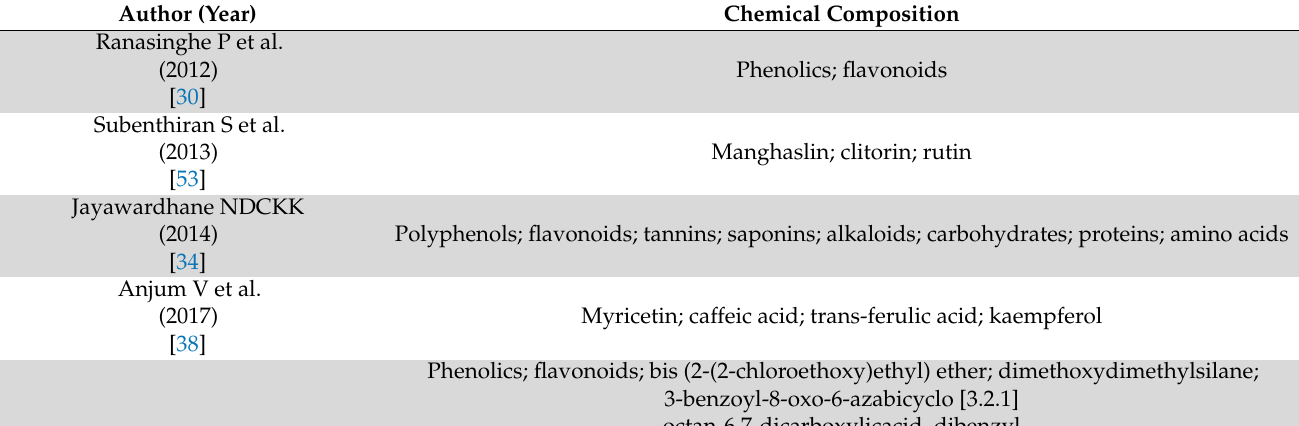
Table 4. Summary of chemical compositions identified in Carica papaya leaf juice by 10 included